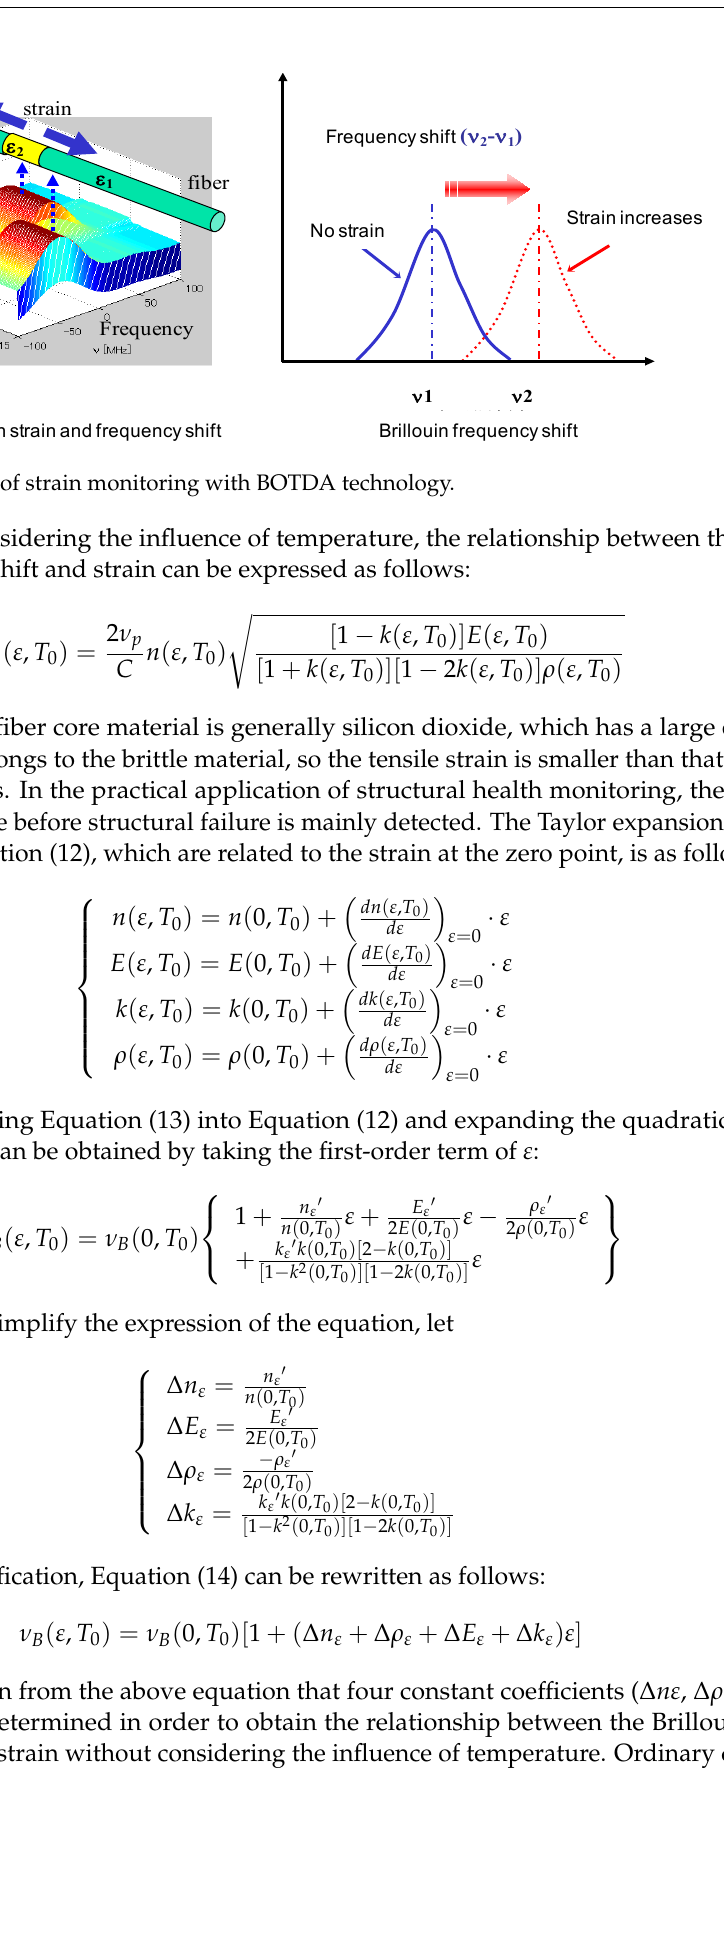
3. Basic Theory of Optical Fiber Sensor for Rock Mass Deformation Monitoring